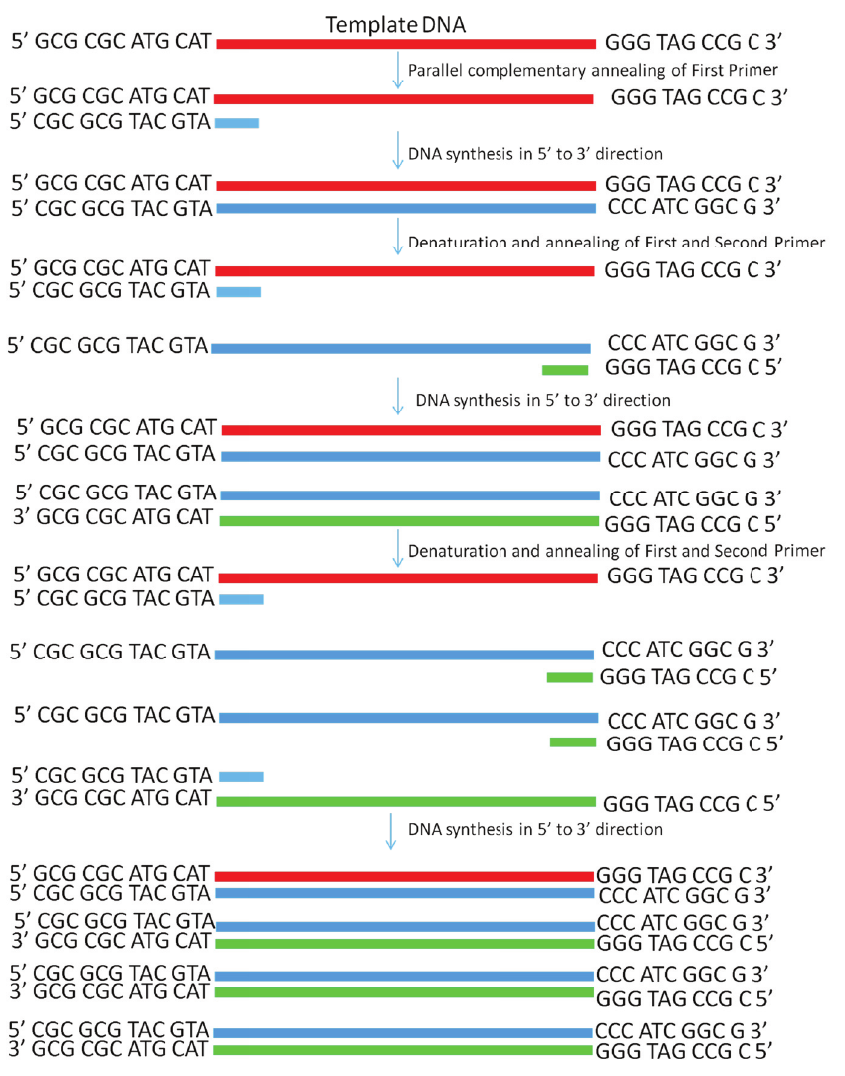
Figure 2. Schematic diagram showing PCR amplification of a single-stranded DNA by using the PD-PCR (parallel DNA PCR) approach in which the first primer binds to the template DNA in a parallel complementary manner. The second primer binds to the newly synthesized DNA in an antiparallel manner and later both primers amplify the new DNA in a conventional manner. PCR products obtained will have opposite polarity as compared to the template